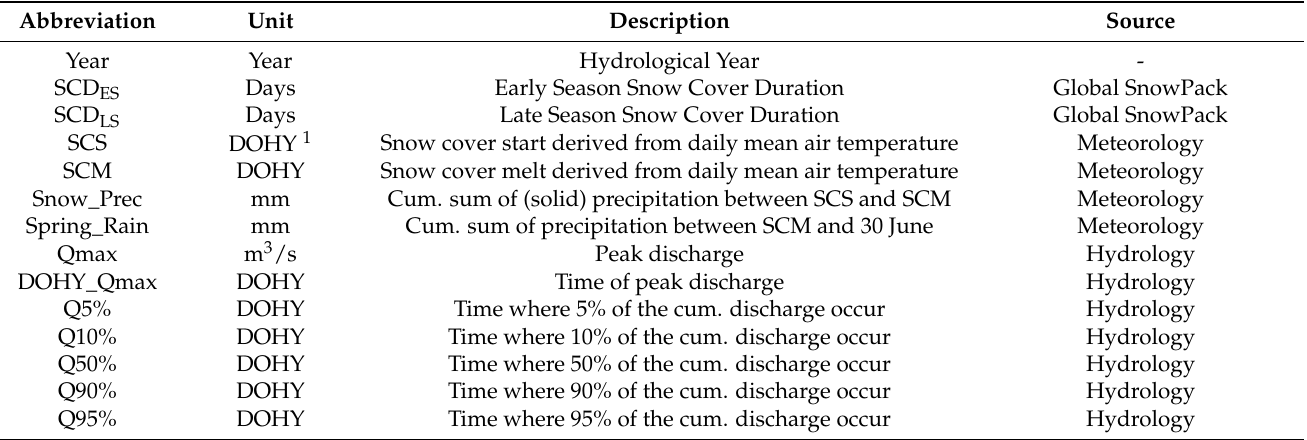
Table 2. Measures for spring flood timing and